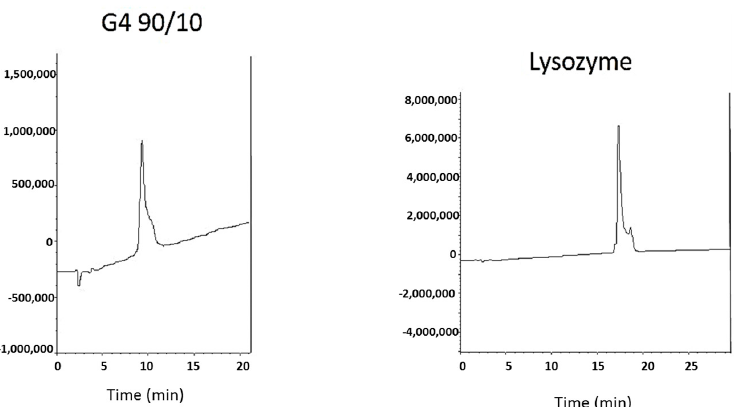
Figure 4. Isoelectric focusing (IEF) of G4-90/10 dendrimer. The top half of the gel is acidic and the bottom half is alkaline. Lanes 1 and 2 are lysozyme (pI 11.0); lane 3 is amyloglucosidase (pI 3.5; protein barely entered the gel); lane 4 is myoglobin (pI 6.8), lane 5 is ribonuclease A (pI 9.5), lane 6 is cytochrome c (pI 10.7); and lanes 7 and 8 are G4-90/10 dendrimers.